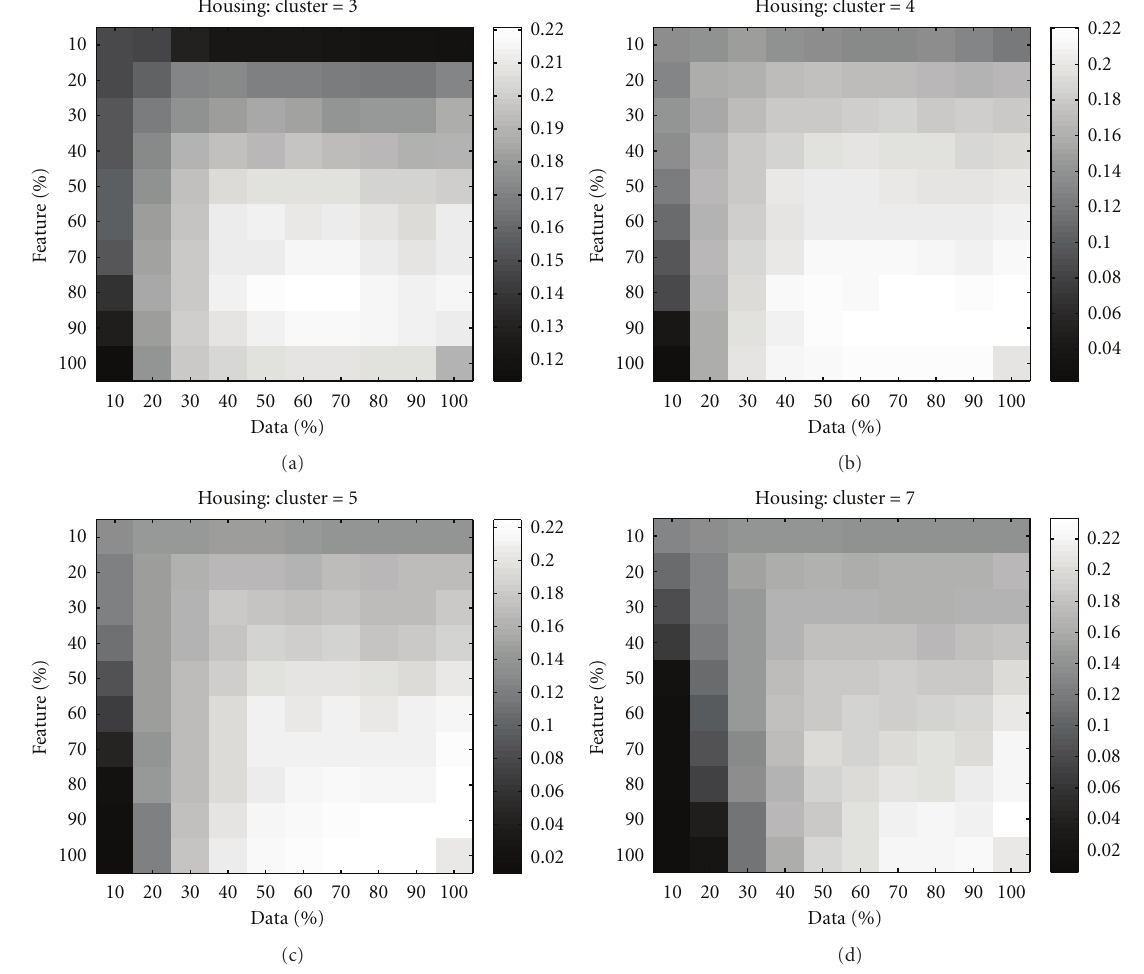
Figure 8: Heat map for housing data for c = 3, 4, 5, and